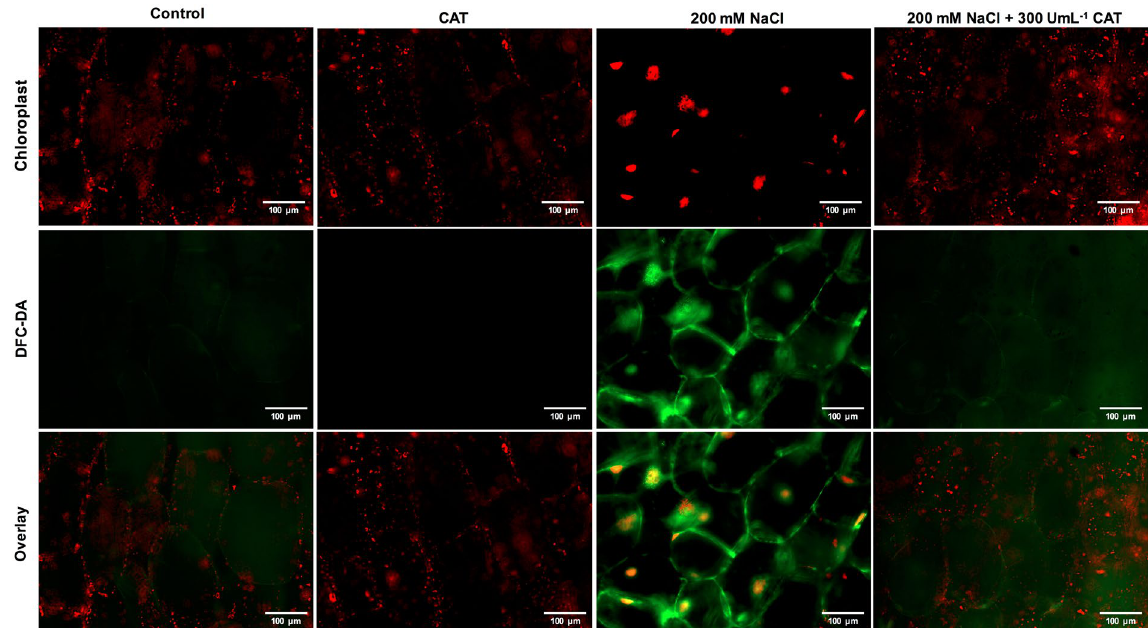
Figure 6. Effects of exogenous CAT application on H 2 O 2 in the Opuntia streptacantha cells exposed to 200 mM NaCl. Representative images of O . streptacantha cells and their chloroplasts are shown in each panel. Segments of cladode were exposed to 200 mM NaCl, 200 mM NaCl + 300 UmL − 1 CAT and as control 300 UmL − 1 CAT under white light conditions (300 µ mol m − 2 s − 1 ) for 8 h. Consequently, all treatments were incubated with 25 μ M 2 ′ , 7 ′ –dichlorofluorescein diacetate (DCF-DA). Changes of fluorescence intensity in cells was observed using an Epi-fluorescence microscope. Scale bar corresponds to 100 μ